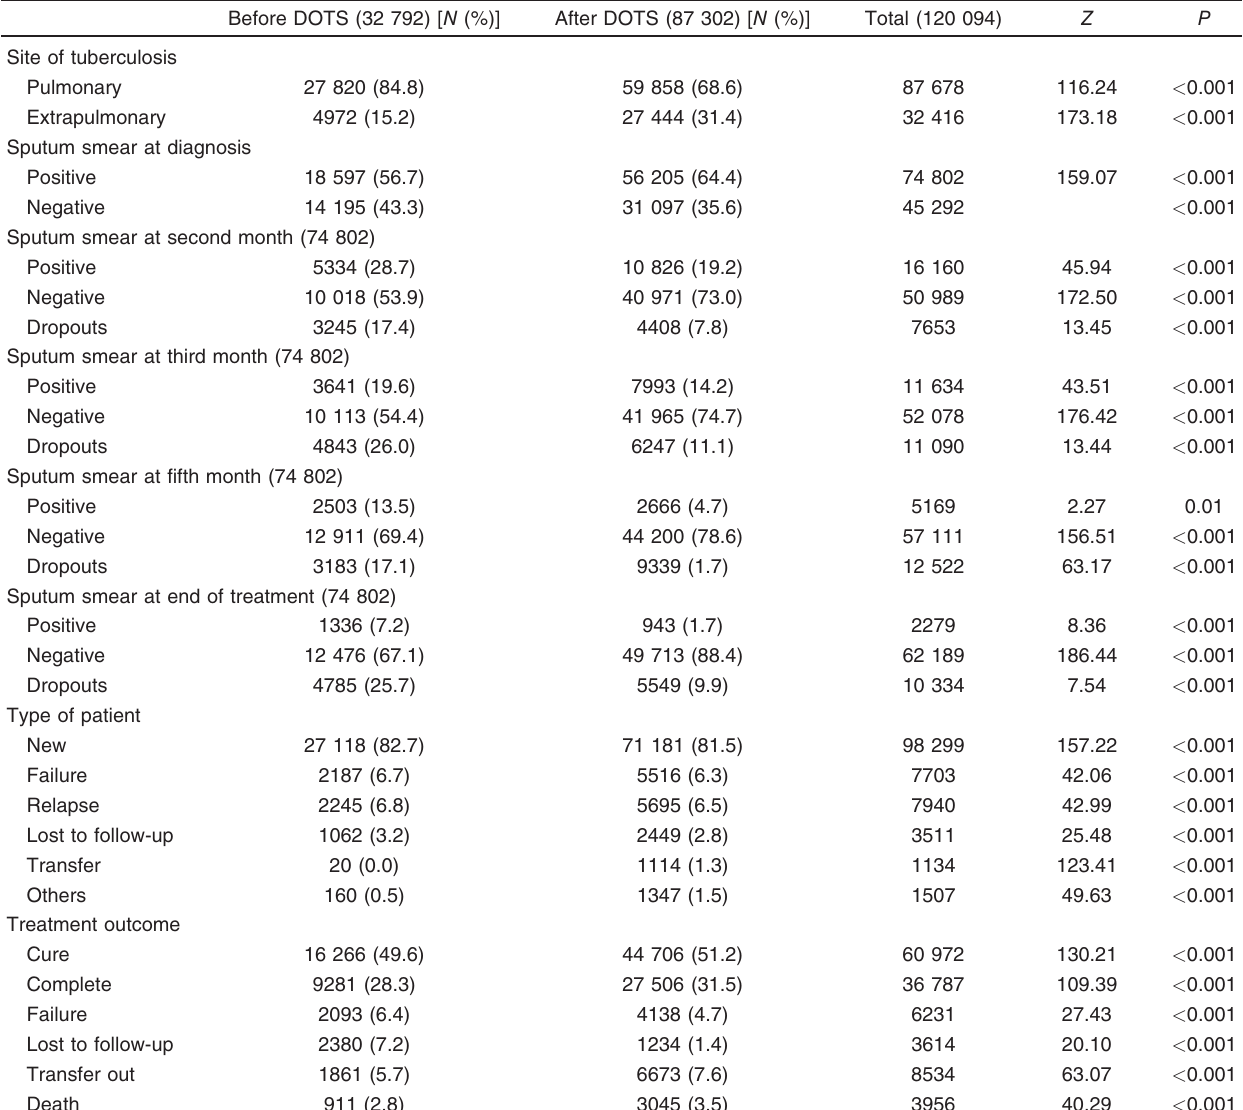
Table 6 Comparison between tuberculosis disease criteria before and after directly observed treatment short-course strategy Before DOTS (32 792) [ N